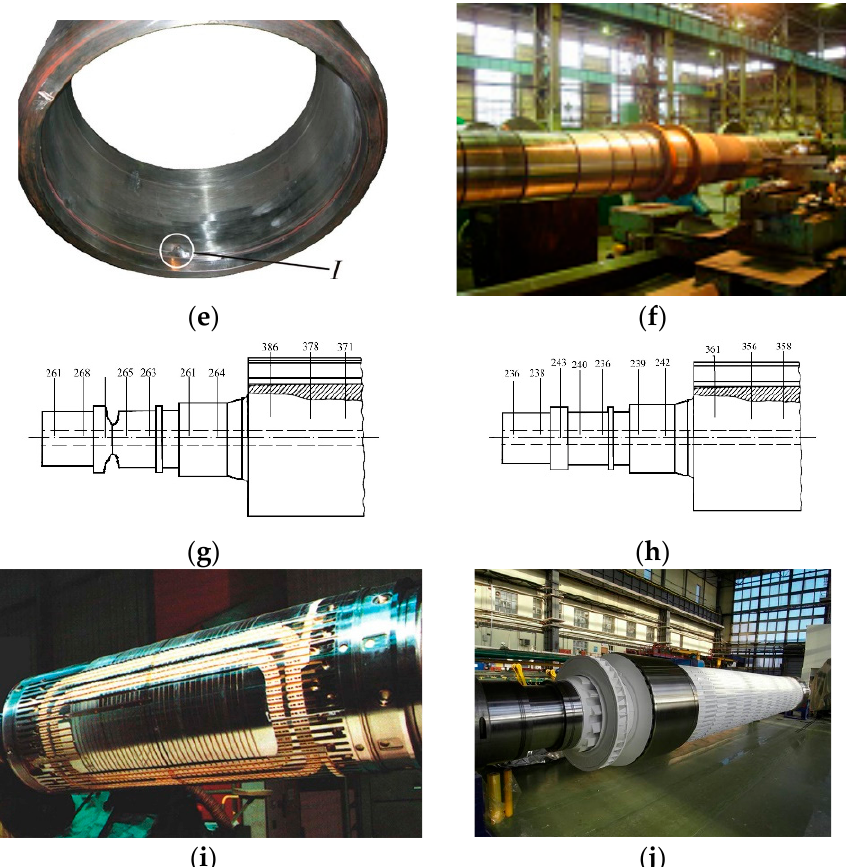
Figure 18. Part of the technological process of removing the rotor from a turbogenerator ( a , b ), a damaged turbogenerator rotor ( c ), the damaged outer ( d ) and inner ( e ) surfaces of a retaining ring, LCL applied in the TA during repair ( e ) with increased hardness ( g , h ), and the assembly of hydrogen-cooling channels ( i ) and the retaining ring after repair ( j ) [41,82,84,142,144].